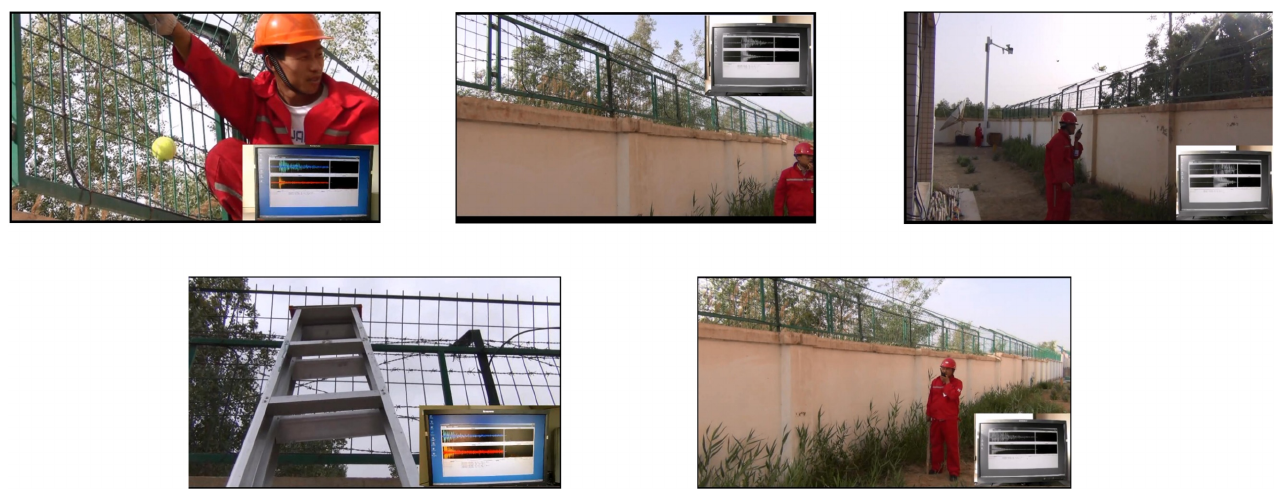
Figure 4. Field acquisition of partial vibration signals. Table 1. Number of various types of